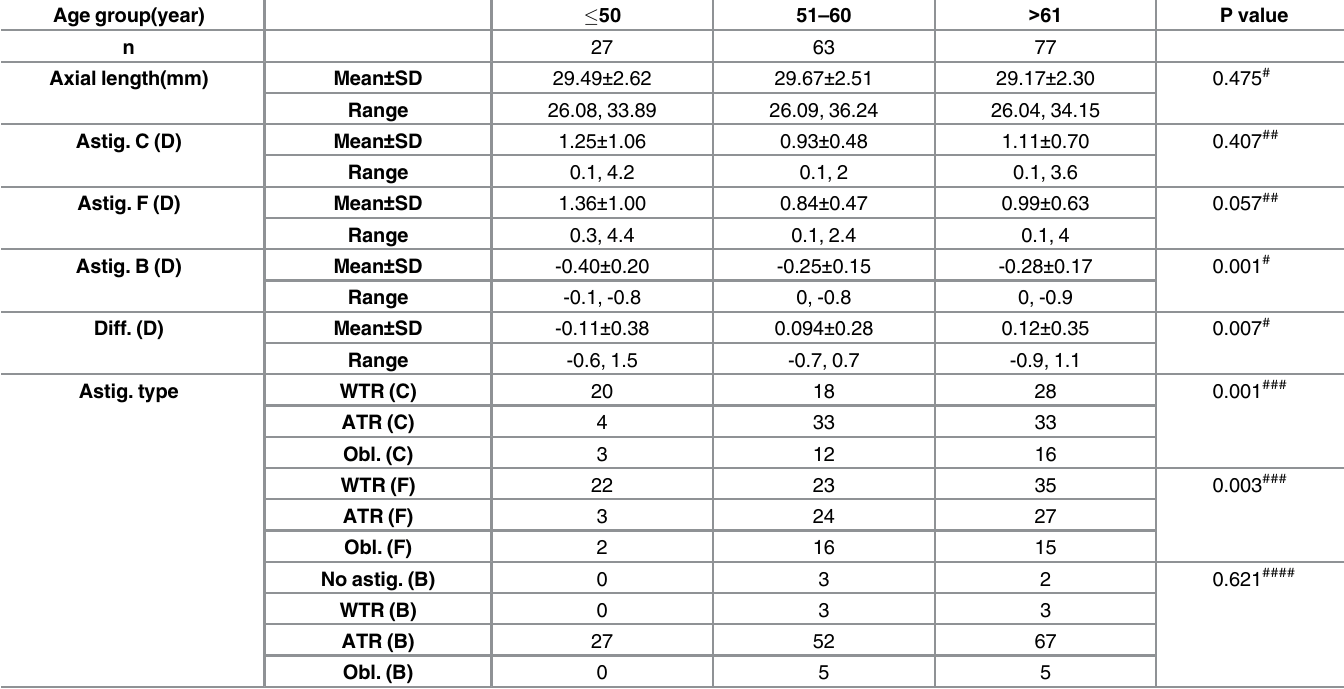
Table 4. Corneal characteristics of high myopia by